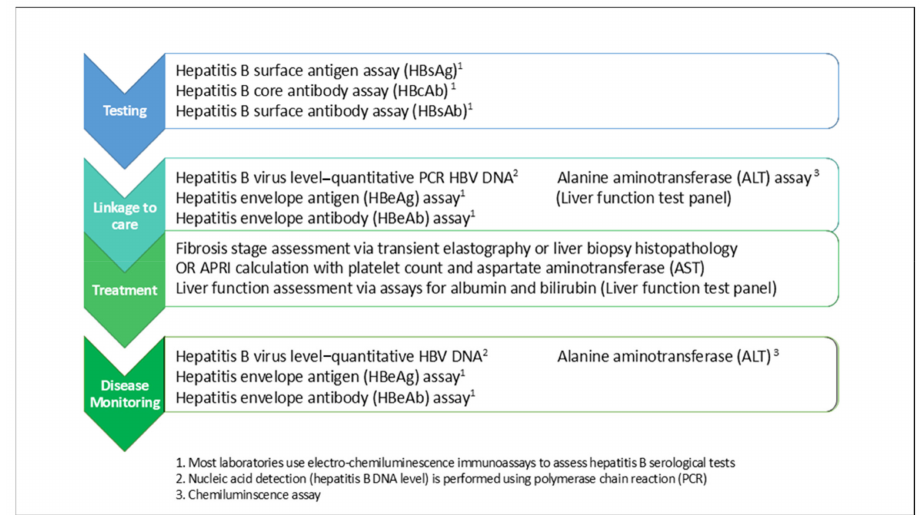
Figure 1. Cascade of care for hepatitis B and laboratory-based tests required for standard of